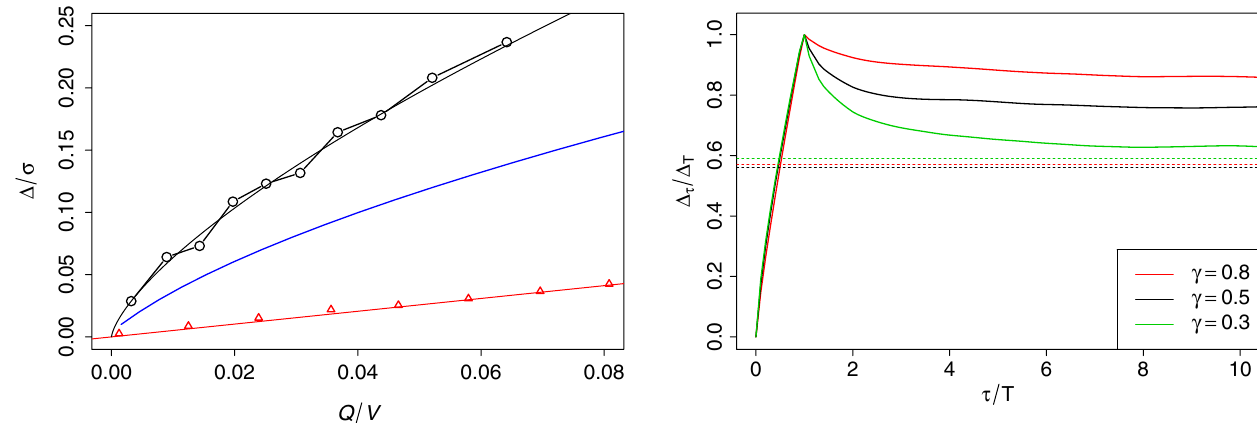
FIG. 5. Left: The true impact of (cid:11) -executed metaorders for (cid:10) ¼ 0 : 5 , (cid:2) ¼ 0 : 3 (black circles), the naive estimate of the impact from integrating the volume in the average latent order book (blue solid line), and the average price change against the global volume imbalance in a given period (red triangles). We also show a power-law fit for the metaorder impact, as Y ð Q=V Þ (cid:2) , with (cid:2) ¼ 0 : 7 and Y ¼ 1 : 59 (solid black line) and a linear fit for the global measure of impact (solid red line). Right: The decay of impact after the completion of the metaorder for the unit execution for (cid:10) ¼ 0 : 3 , 0.5, and 0.8 and (cid:2) ¼ 0 : 5 . The x axis is (cid:7)=T , the clock time in units of the time needed to complete the metaorder (with T (cid:8) (cid:7) life ), the y axis is the rescaled price change during the metaorder. After the metaorder, the price appears to relax to a constant level, which is a (cid:10) dependent fraction of the temporary impact. The dotted horizontal lines correspond to the actual average execution price of the metaorder, which is found to be (cid:1) 0 : 6(cid:1) T for all three values of (cid:10)